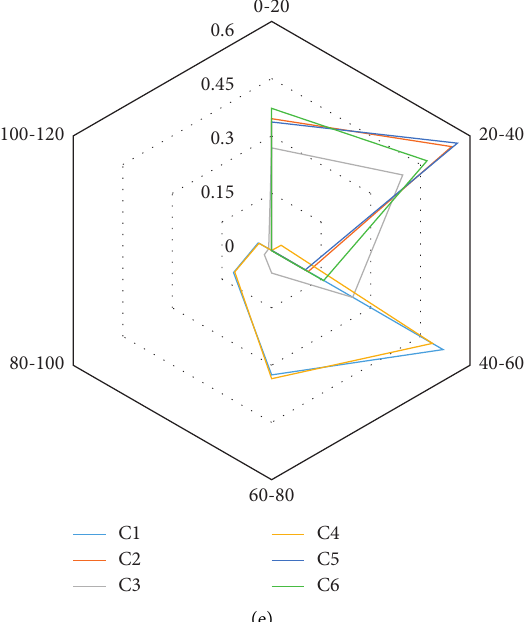
Figure 8: Six mobility patterns recognized by the proposed method when δ � 16 and ε � 9 . 5. (a) POI categories around the origin station. (b) POI categories around the destination station. (c) The start time of the day. (d) The day of week. (e) Travel